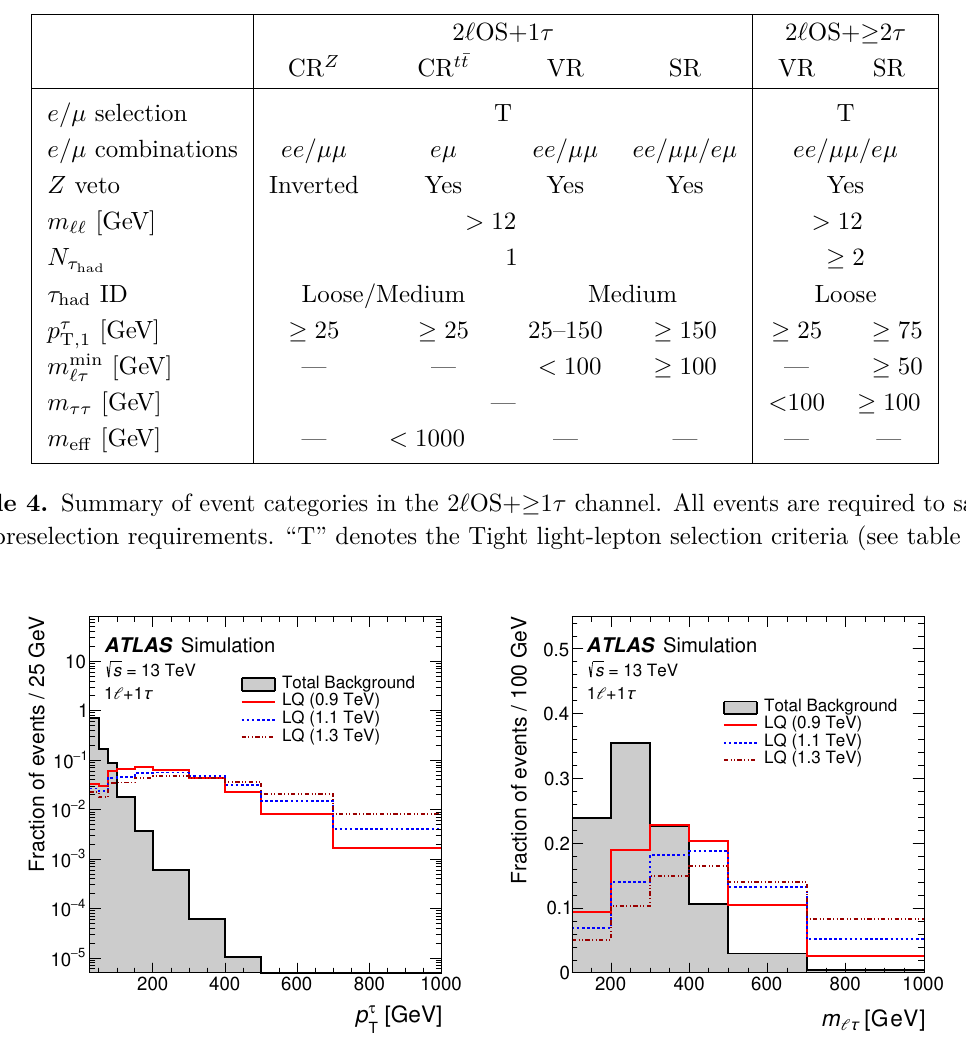
Figure 1. Comparison of the distribution of (a) the p T of the τ had candidate ( p τ invariant mass of the light lepton and the τ (shaded histogram) and the LQ signal for different mass values. The selection used corresponds to events in the 1 ‘ +1 τ event category (a) after the preselection requirements, and (b) after